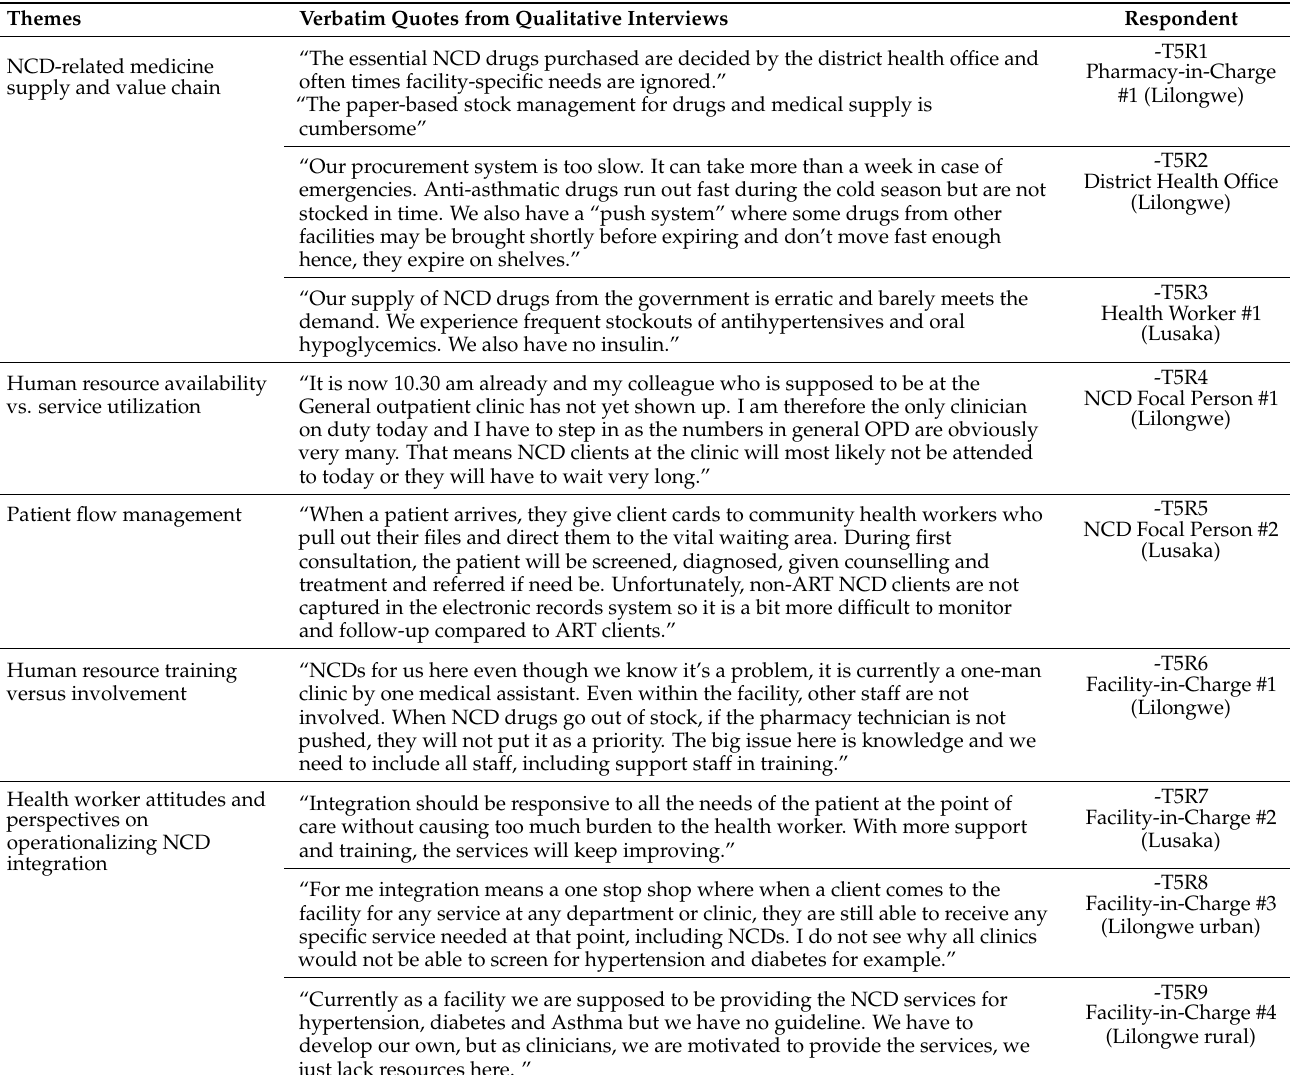
Table 3. Respondents (health personnel) perspectives of NCD